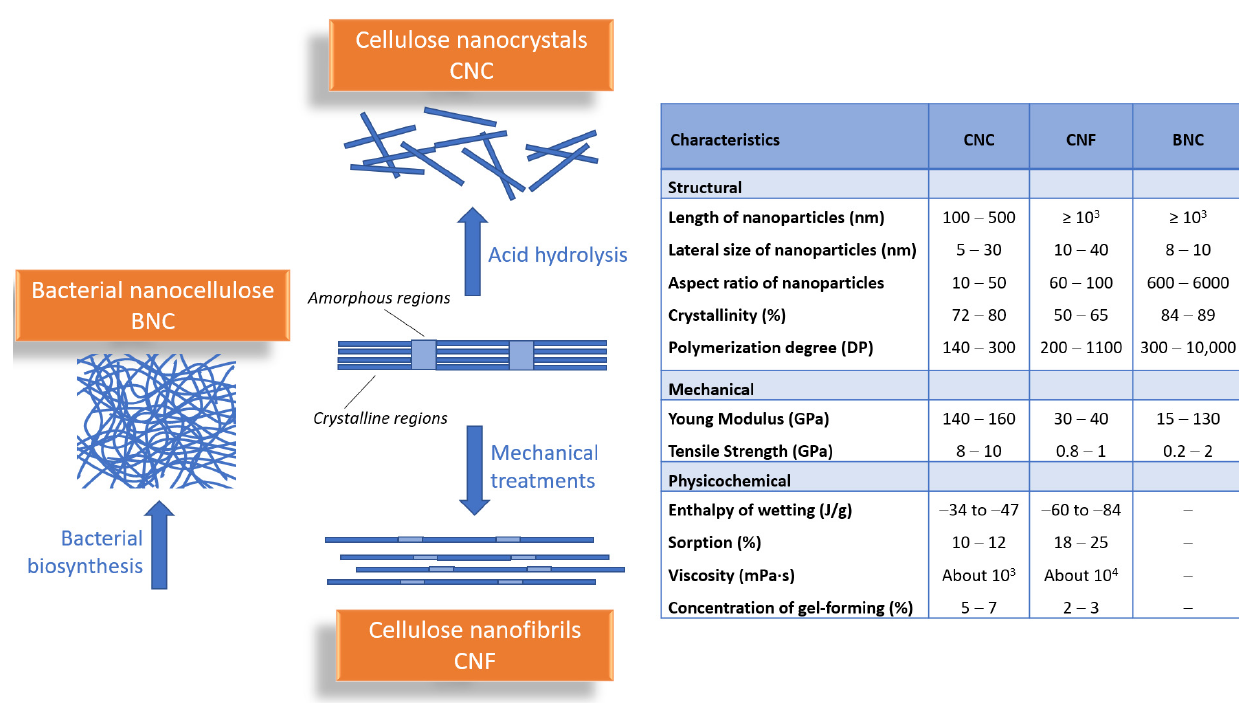
Figure 1. Preparation scheme and dimensions of different types of nanocelluloses: nanocrystalline cellulose, nanofibrilar cellulose, and bacterial nanocellulose.